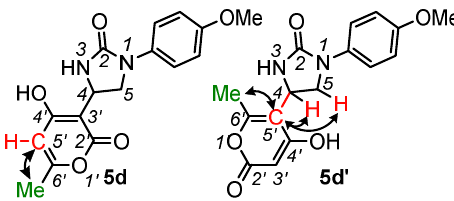
Figure 4. Structure determination of the compounds 5d and 5d′ . Key cross-peaks in the 1 H- 13 C HMBC spectra are indicated by arrows.